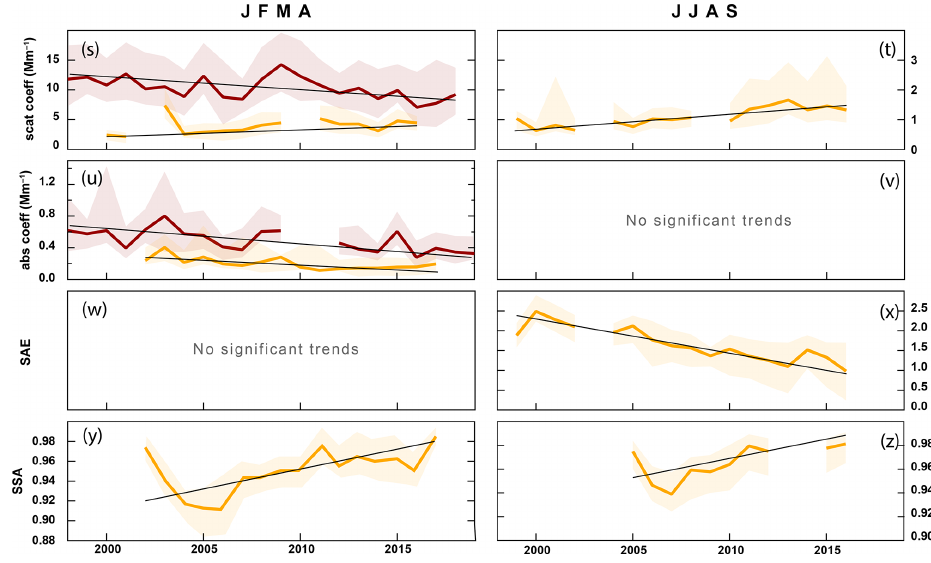
Figure 3. Significant trends ( p< 0 . 05) per variable and station for the entire time period over which data are available. For Villum we considered the time period 2008–2016 here. MSA is given for the months of April–May and